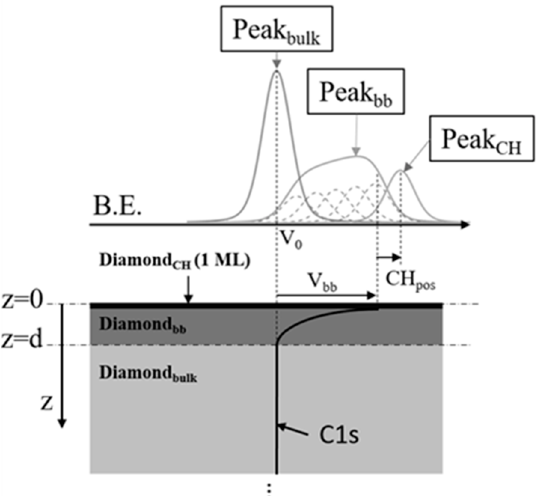
Figure 4. XPS model diagram for C 1s peak analysis. The sample was divided into three regions: diamond bulk (Diamond bulk ) for z ϵ [ d , + ∞ ); diamond with band bending (Diamond bb ) for z ϵ [1 ML, d ]; and diamond surface C–H x (Diamond CH ) for z ϵ [0, 1 ML]. The area ratio of XPS peaks (Peak bulk , Peak bb and Peak CH ) is obtained as in Equation (2). Diamond bulk and Diamond CH XPS contributions follow Voigt distributions while the Diamond bb distribution is obtained from a convolution (see Section 3) and is defined by its band bending width, d , and maximum potential, V bb . The peak C–H position (CH pos ) is defined relative to V bb and was set to +0.5 ± 0.15 eV.